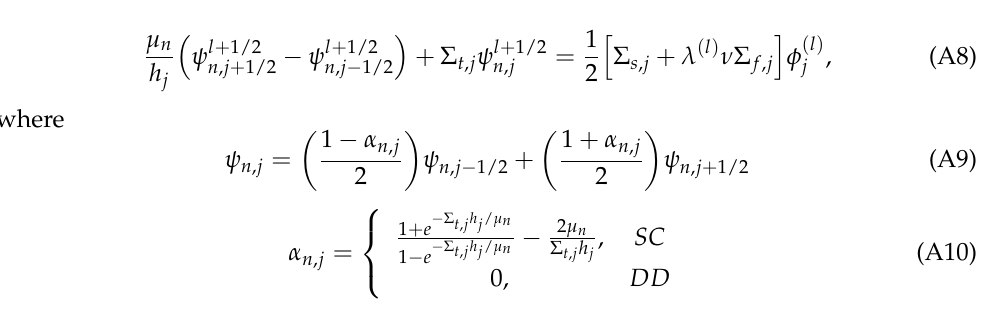
h j mesh size of fine-mesh cell j . The diffusion equation (Equation (A5)) is solved on a coarse-mesh grid, where each coarse cell consists of p fine-mesh cells.